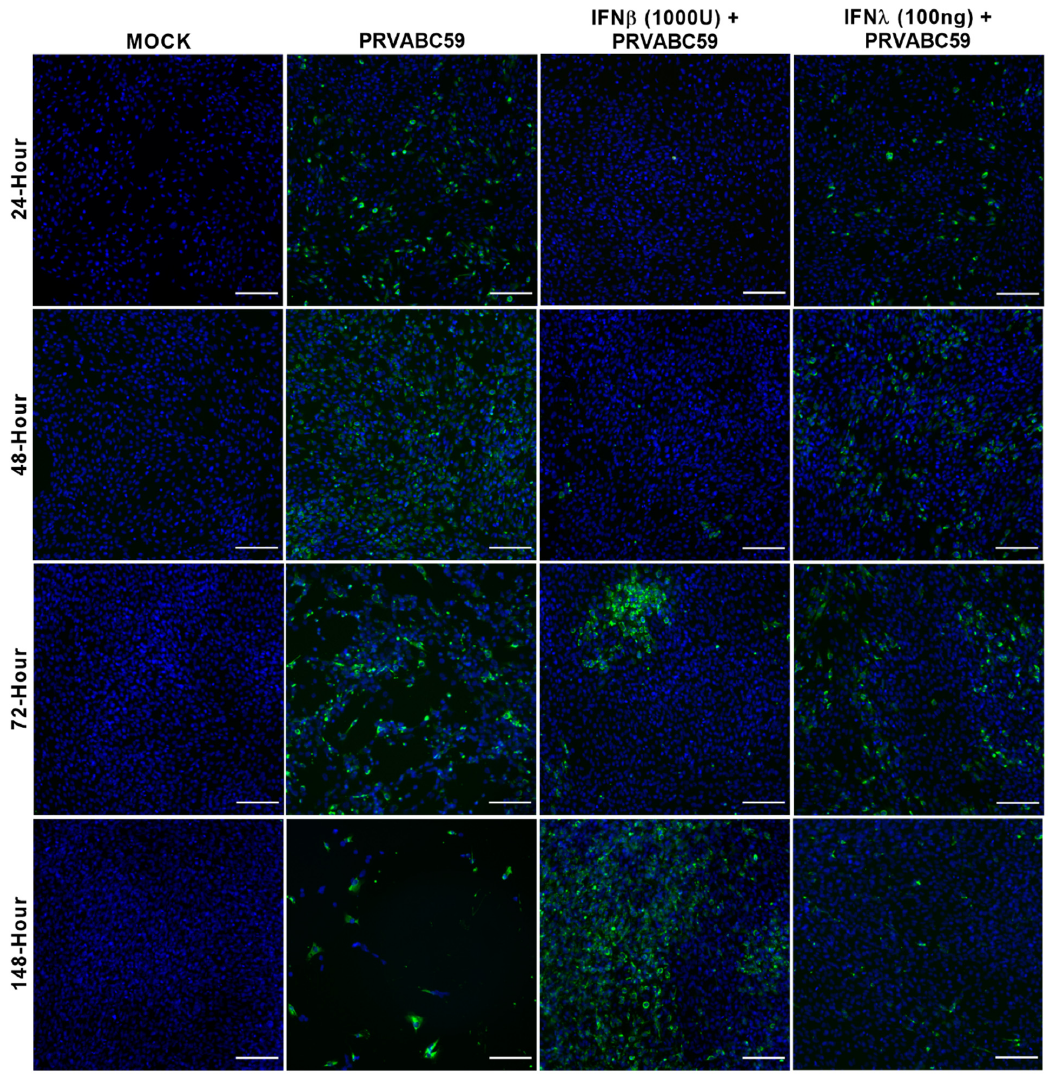
Figure 5. IFN- β and IFN- λ pre-stimulated ZIKV-susceptible HASTR/ci35 astrocyte cells partially control Zika virus strain PRVABC59 infection. Subconfluent ZIKV-susceptible HASTR/ci35 astrocyte cells were incubated with a low concentration of IFN- β (1000 U/mL) and IFN- λ (100 ng/mL) for 18 h followed by inoculation with PRVABC59 ZIKV strain at an MOI of 0.1. IFN- β showed effective control of the virus at an earlier timepoint but was unable to control persistently, whereas IFN- λ showed persistent but partial control of the virus. Cells were fixed at 24-, 48-, 72- and 148-hour timepoints and then stained with 4G2 antibody to detect ZIKV envelope protein Env (stained green) and DAPI stain for cell nuclei (stained blue). Scale bars represent 200 µ